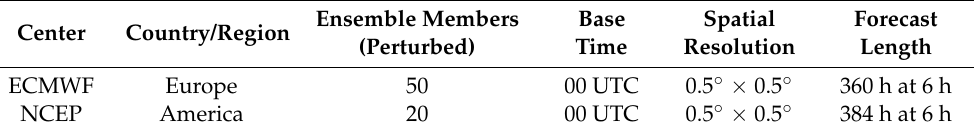
Table 1. The ensemble precipitation